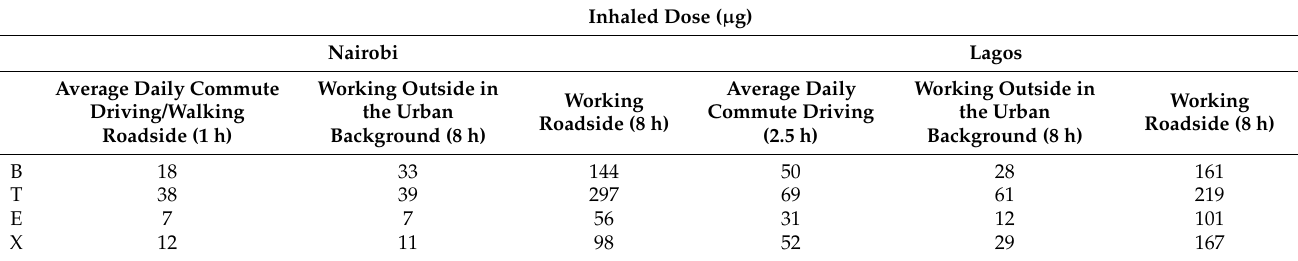
Table 4. Potential exposure doses of workers in Nairobi and